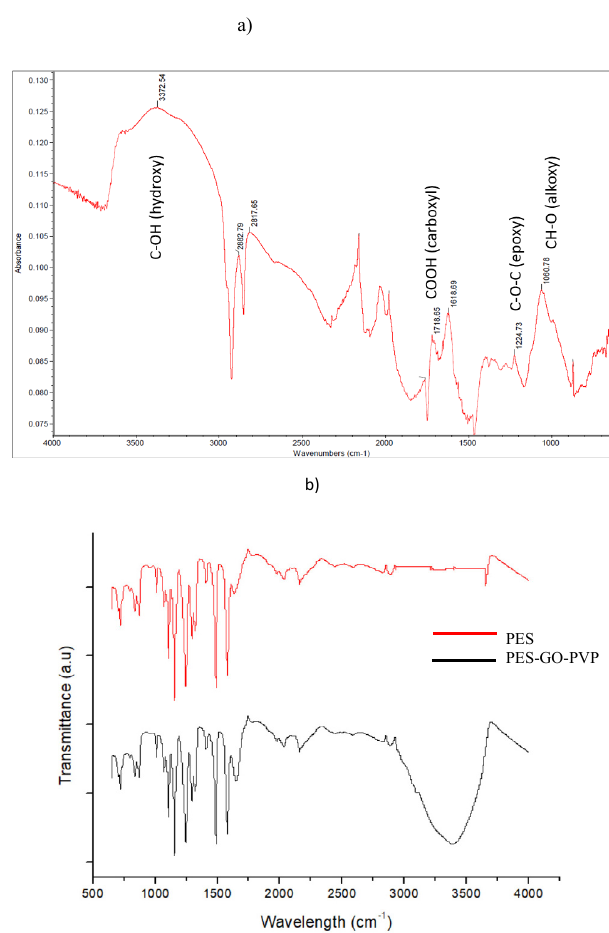
Fig. 1. FTIR spectrum of a) powder form of GO and b) bare PES and PES-GO-PVP